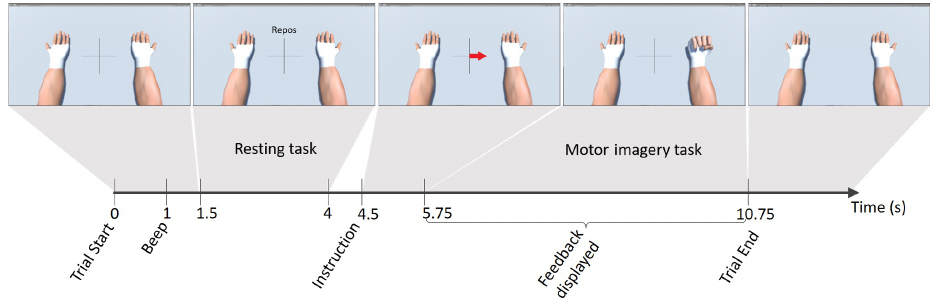
Figure 3. Timing of a